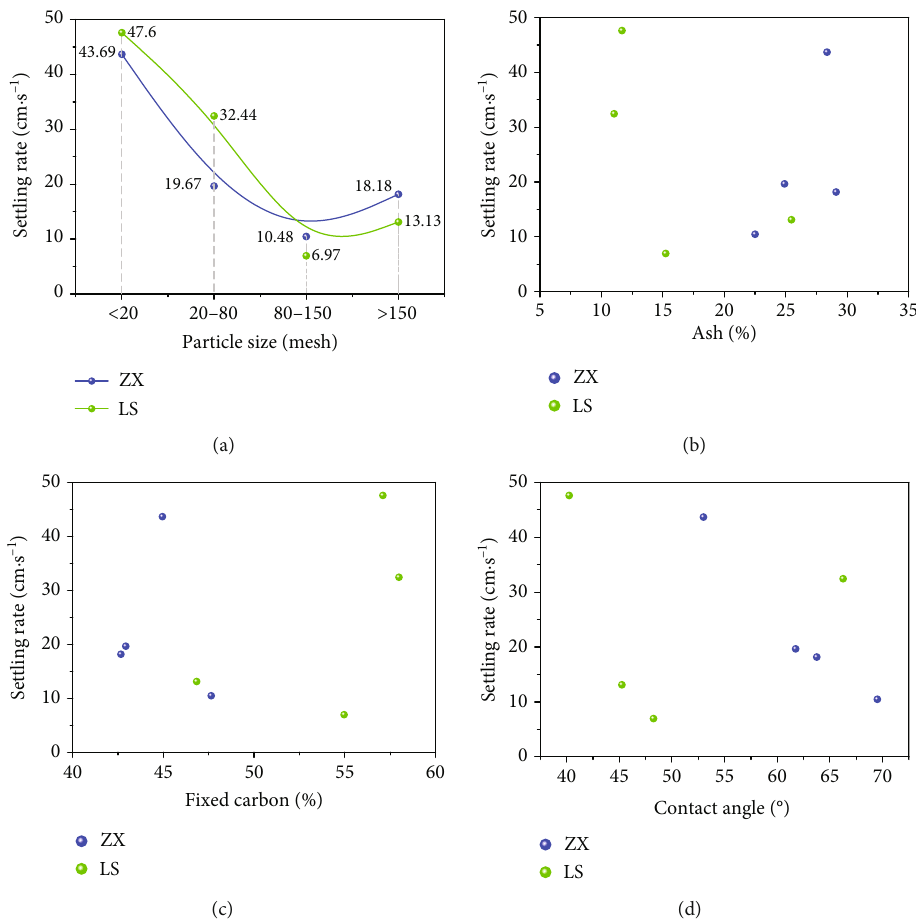
Figure 13: Settling rates of di ff erent coal fi nes and analysis of its in fl uence factors ((a) di ff erent settling rates of coal fi nes, (b) relationship between settling rate of coal fi nes and ash content, (c) relationship between settling rate of coal fi nes and fi xed carbon content, and (d) relationship between settling rate of coal fi nes and contact